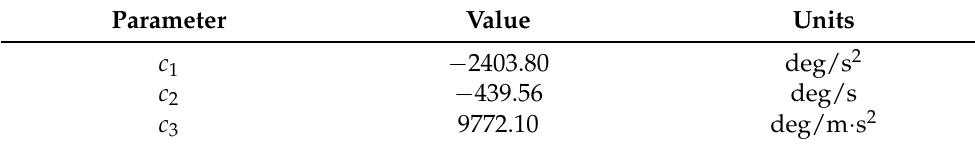
Table 3. Physical parameters.